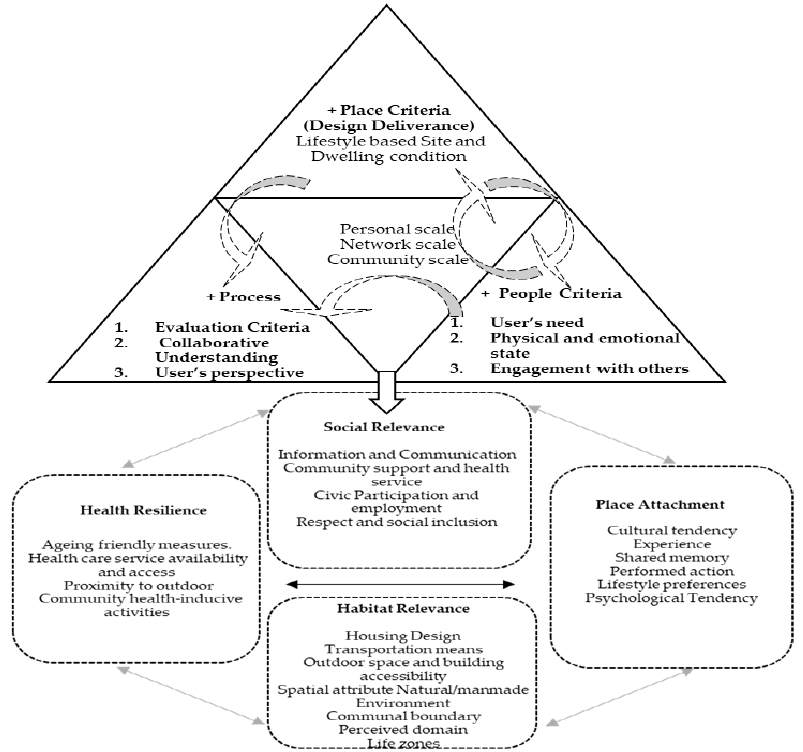
Figure 9. Re-distributed criteria for aging-in-place.